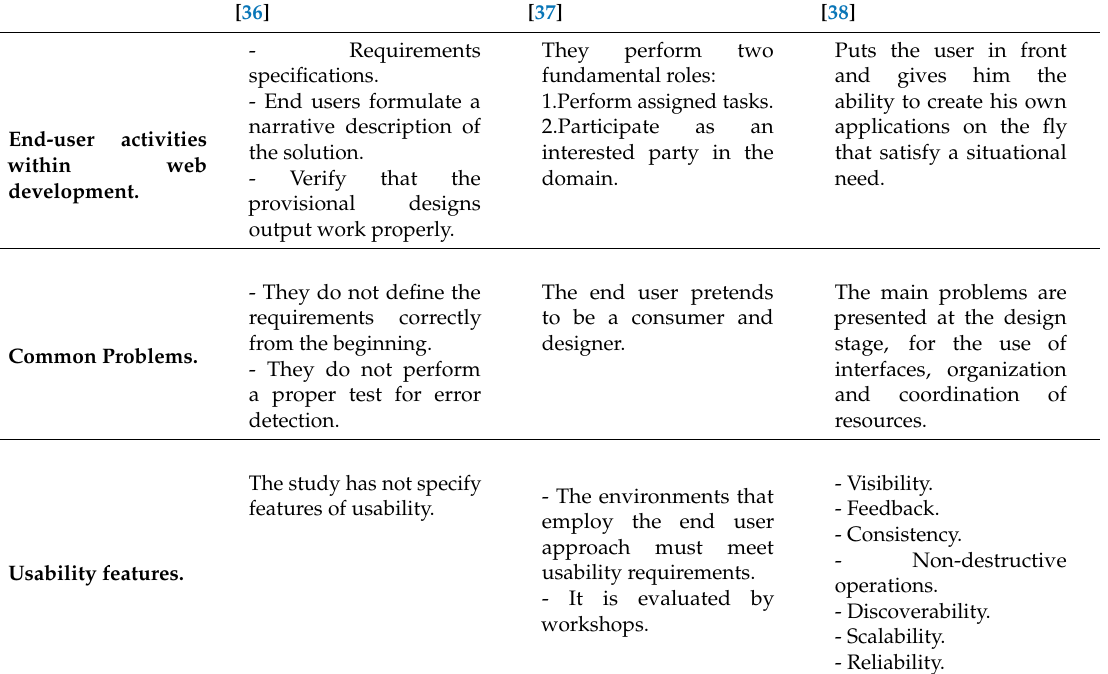
Table 9. Analysis of data extracted from primary studies regarding hypermedia